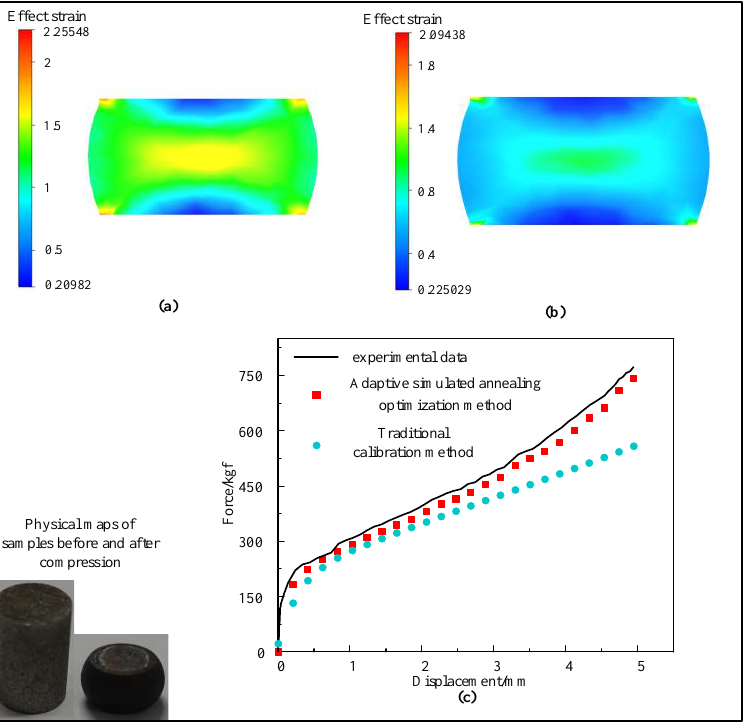
Figure 14. Models of different shapes: ( a ) Ø 8 × 12 mm half sample model; ( b ) the cylindrical sam- ple (Ø 8 × 12 mm) with a notch radius of 1 mm.